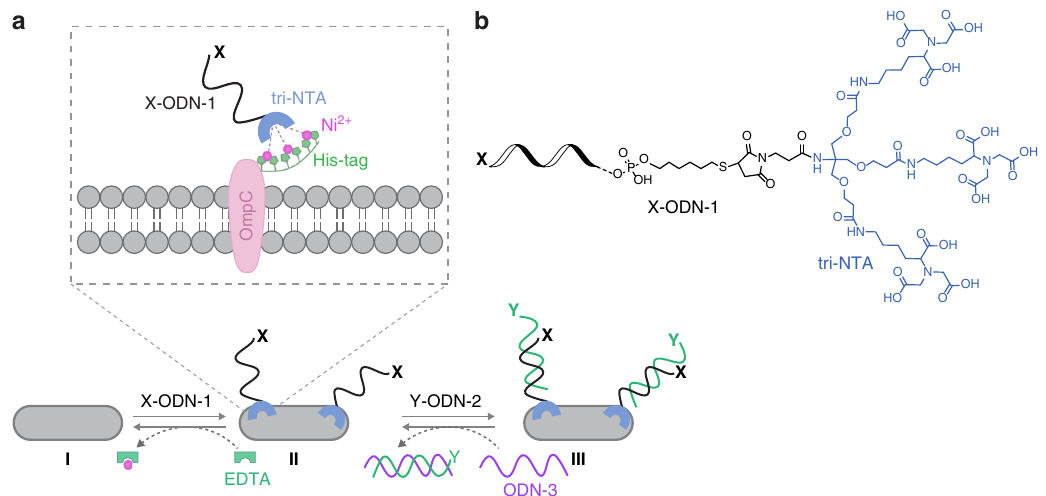
Fig. 1 Design principles. a One way to decorate E. coli with arti fi cial receptors, which are appended with a speci fi c functionality ( X ), involves the binding of X - ODN-1 to a hexa-histidine tag (His-tag) fused to OmpC (I → II). This process can be reversed by subjecting the bacteria to EDTA (II → I). Another way to introduce an unnatural recognition motif ( Y ) to the bacterial surface is by adding to the bacteria decorated with ODN-1 a complementary strand modi fi ed with the desired functionality ( Y -ODN-2, II → III). Y-ODN-2 can be selectively removed by adding a complementary strand, ODN-3 (III → II). b Structure of X